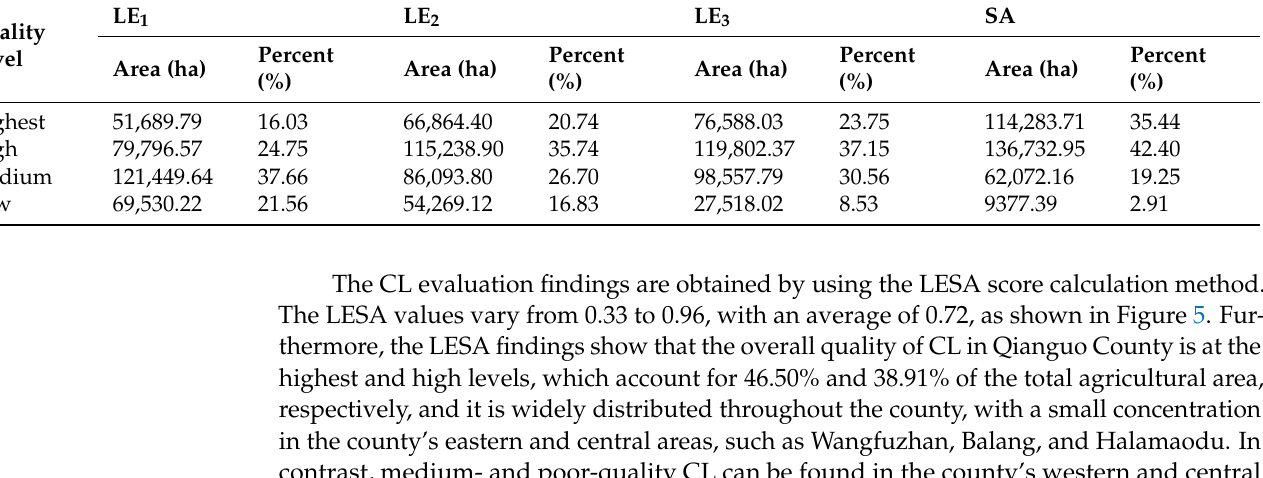
Table 2. Area and percent statistics of each subsystem gradation in Qianguo County.